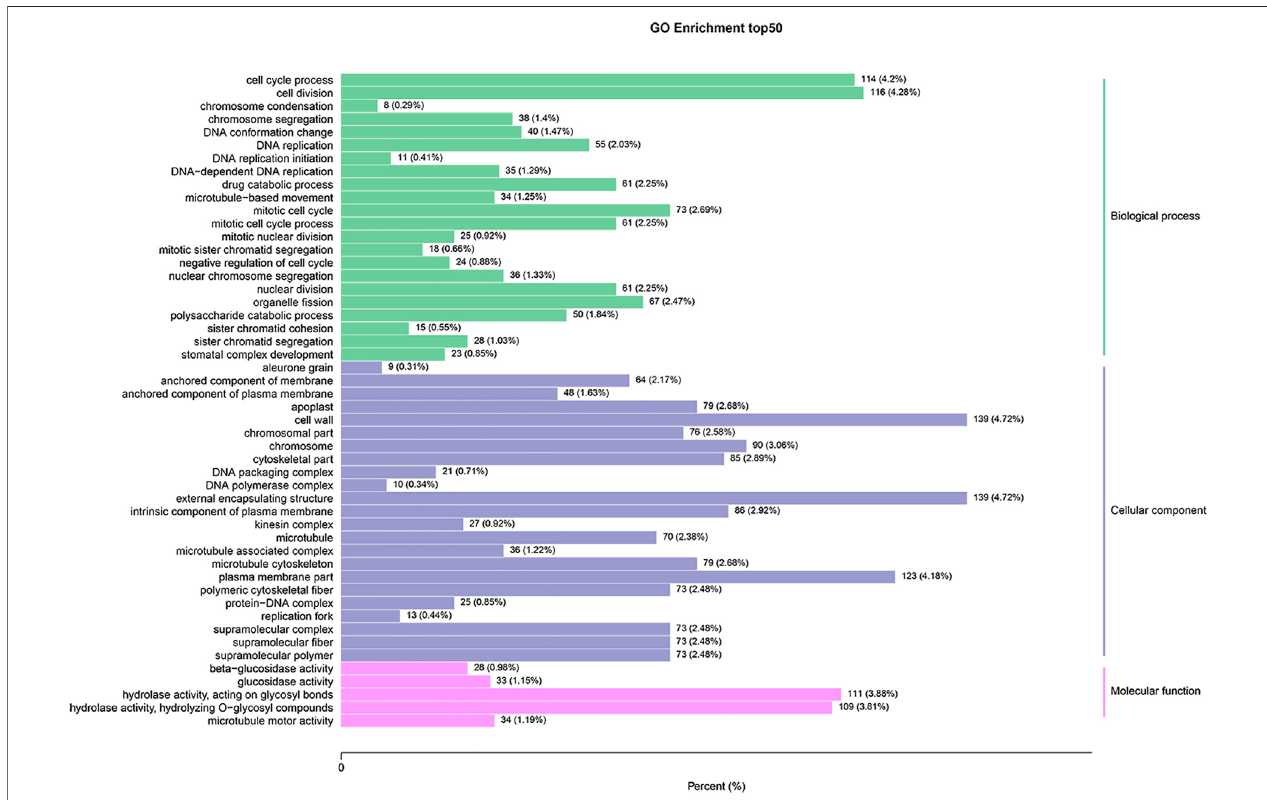
FIGURE2| GOenrichmentanalysisofDEGsbetweenSFsandPFs.Theresultsaresummarizedunderthethreetop-levelontologies:biologicalprocess,molecular function,andcellularcomponent.Thelefty-axisindicatesthepercentage ofaspeci fi cGOcategorysubsumedinoneofthethreemaincategoriesmentionedabove.The right y-axis indicates the annotated gene number expressed in the given sub-category. The downregulated DEGs are indicated in blue, and the upregulated DEGs are in red.